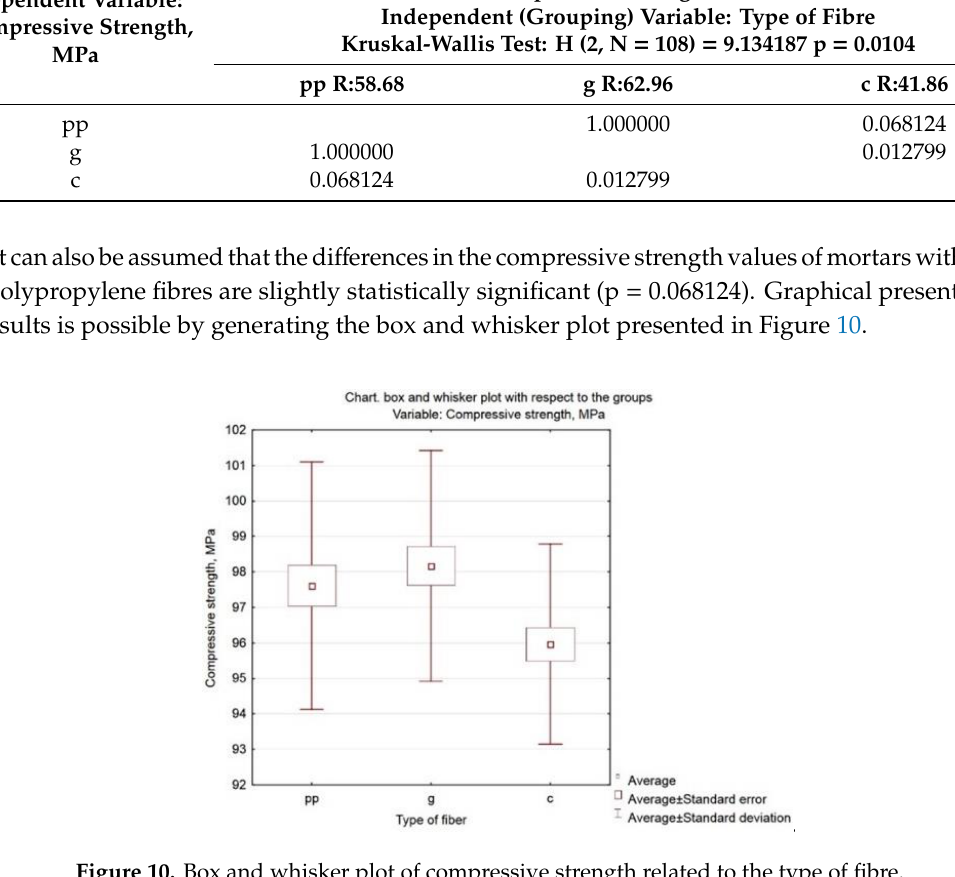
Figure 10. Box and whisker plot of compressive strength related to the type of fibre.